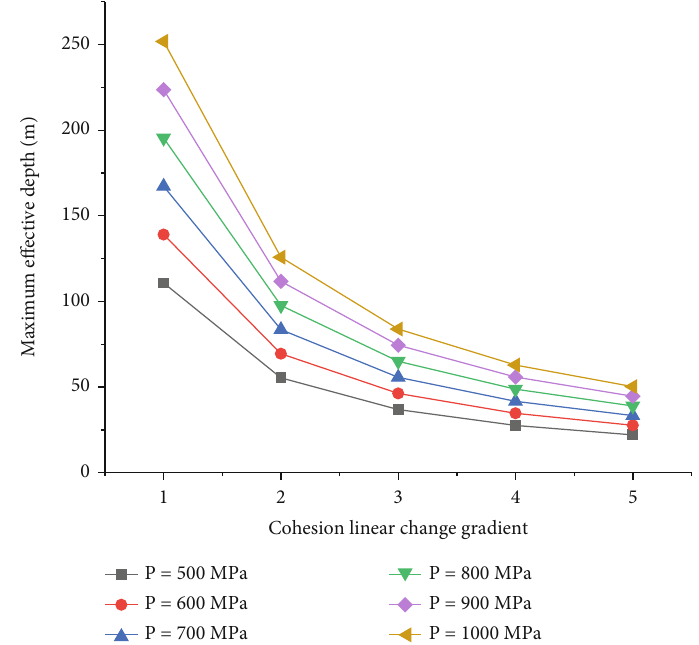
Figure 10: Maximum e ff ective depth of soil under di ff erent nonhomogeneity parameters λ